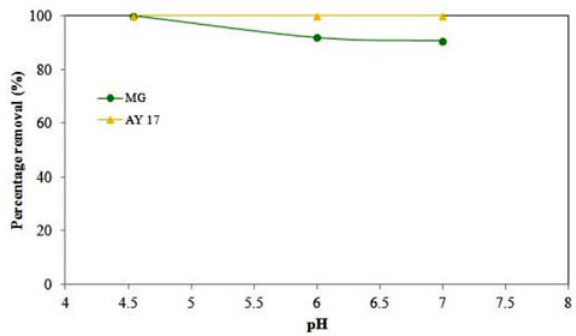
Figure 7. Effect of pH in the removal of MG and AY